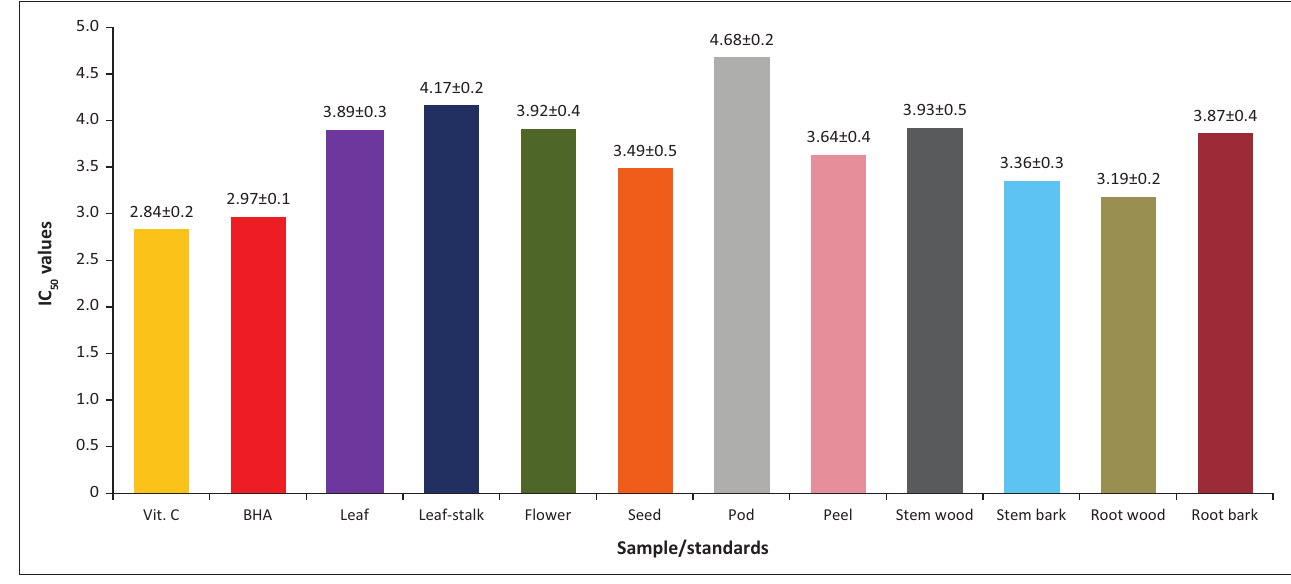
FIGURE 5: The half maximal inhibitory concentration values (mg/mL) for 2,2-diphenyl-1-picrylhydrazyl inhibition of Calophyllum inophyllum Linn.